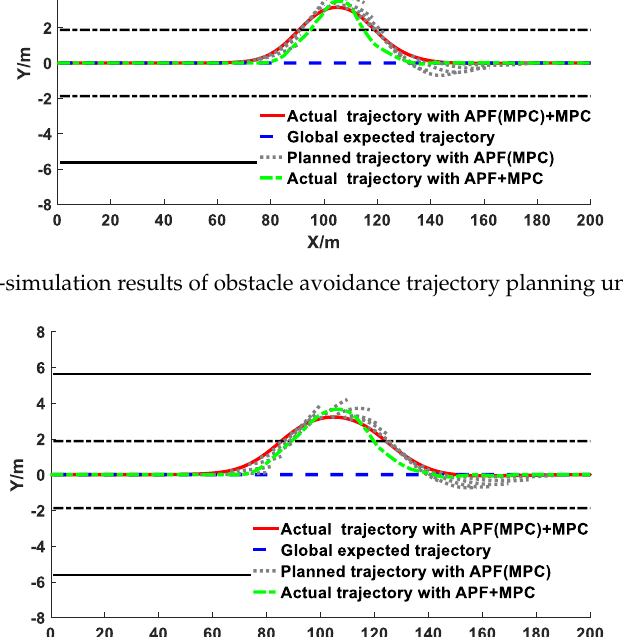
Figure 17. Co-simulation results of obstacle avoidance trajectory planning under 80 km/h.